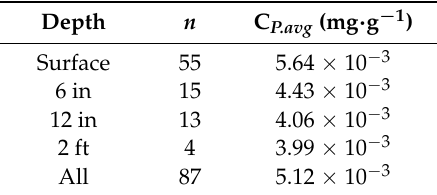
Table 2. The average water-soluble (Fr.W) P concentrations in the sediment. The results are presented in the order of sample depth.